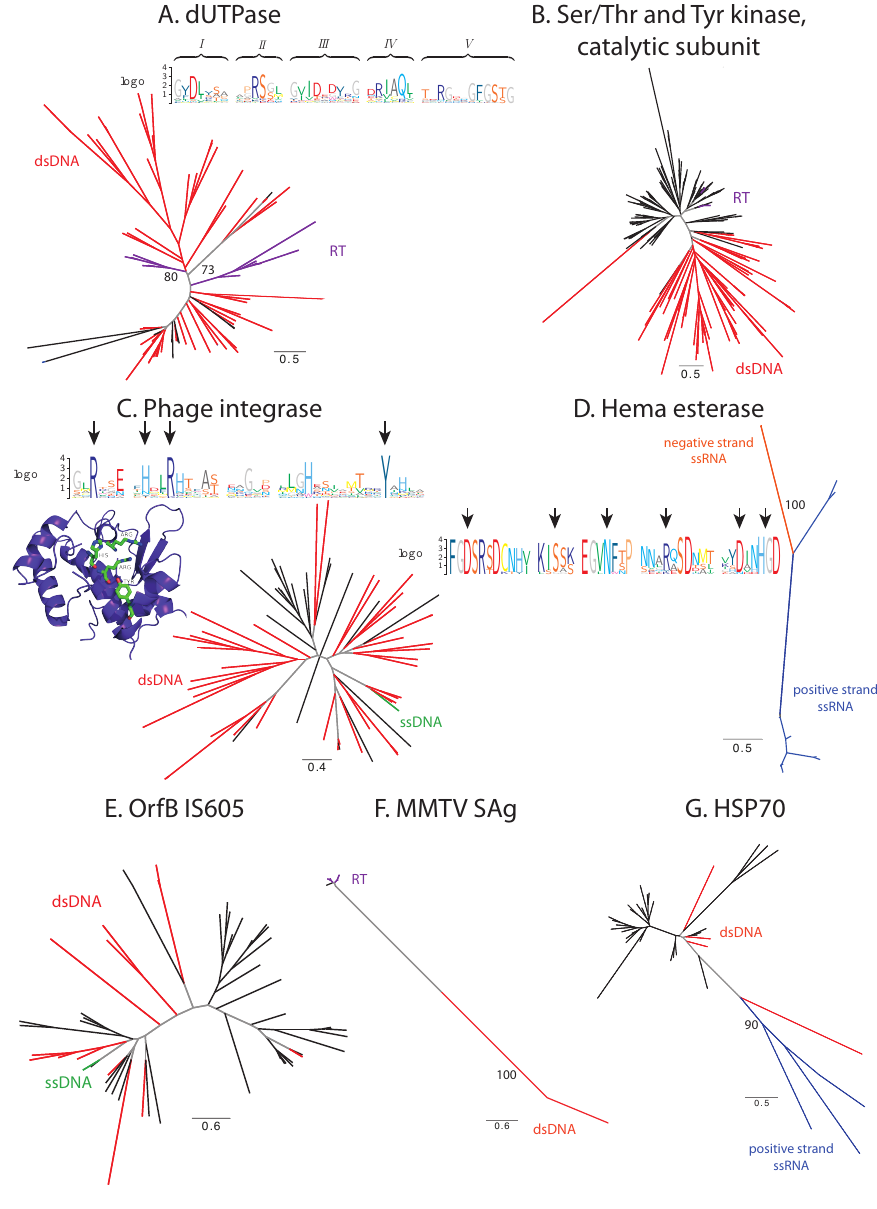
Figure 2. Phylogenetic and conservation analysis in families with unbalanced sequence distribution. ( A ) dUTPase family; ( B ) catalytic domain of serine/threonine and tyrosine kinase family; ( C ) phage integrase family; ( D ) Hema esterase family; ( E ) OrfB IS605 family; ( F ) MMTV SAg family; ( G ) HSP70 family. Branches corresponding to dsDNA viruses are colored red, ssDNA viruses green, positive-strand RNA viruses blue, negative-strand RNA viruses orange, retroviruses purple, proteins from cellular organisms in black and internal branches that do not lead to proteins from monophyletic clades in gray. Functional motifs and catalytic sites are presented in sequence logos and protein 3D structure, where appropriate (discussed in the text). Bootstrap support values are displayed on branches where